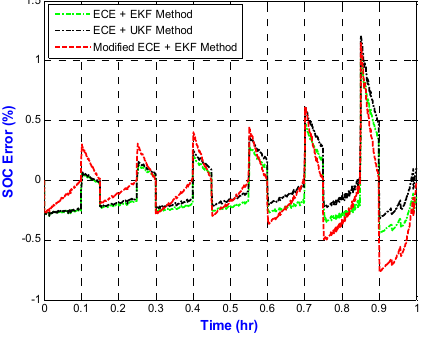
Figure 13. SOC estimation error in Experiment I when the K set to 1.97 × 10 –7 and 6.09 × 10 –8 ,